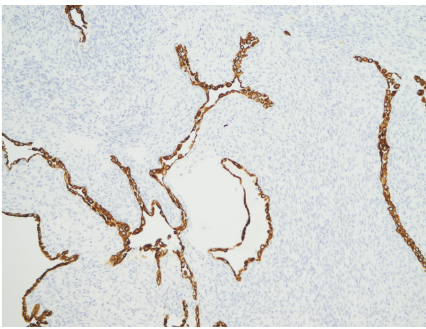
Figure 5: Epithelium lining of cystic spaces showing diffuse and strong positivity for CK7. Immnuoperoxidase stain for CK7; original magnification: 200x.